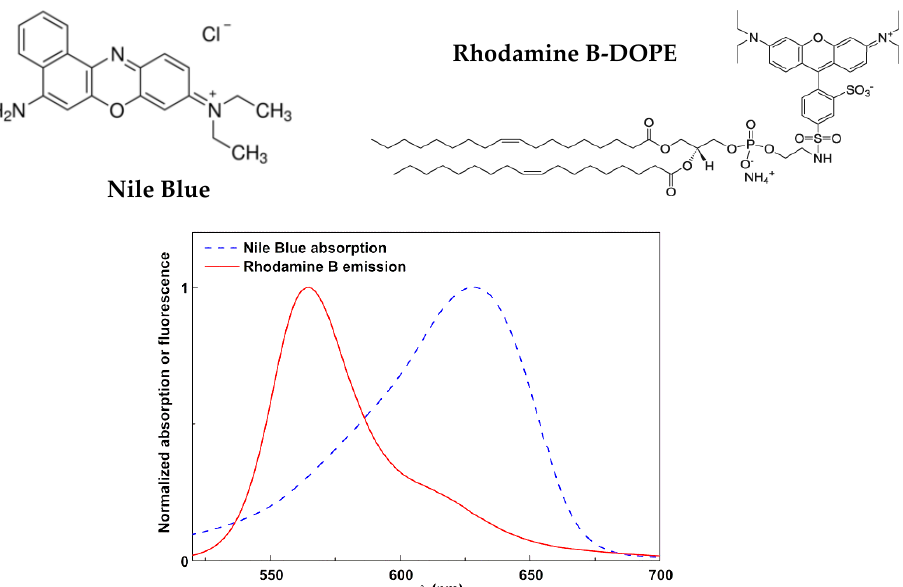
Figure 9. Above: Structure of the dye Nile Blue and the labeled lipid Rhodamine B-DOPE (1,2-dioleoyl- sn -glycero-3-phospho-ethanolamine- N -lissamine rhodamine B sulfonyl (ammonium salt)). Below: Spectral overlap between Rhodamine B emission and Nile Blue absorption, confirming the possibility of Förster resonance energy transfer (FRET).